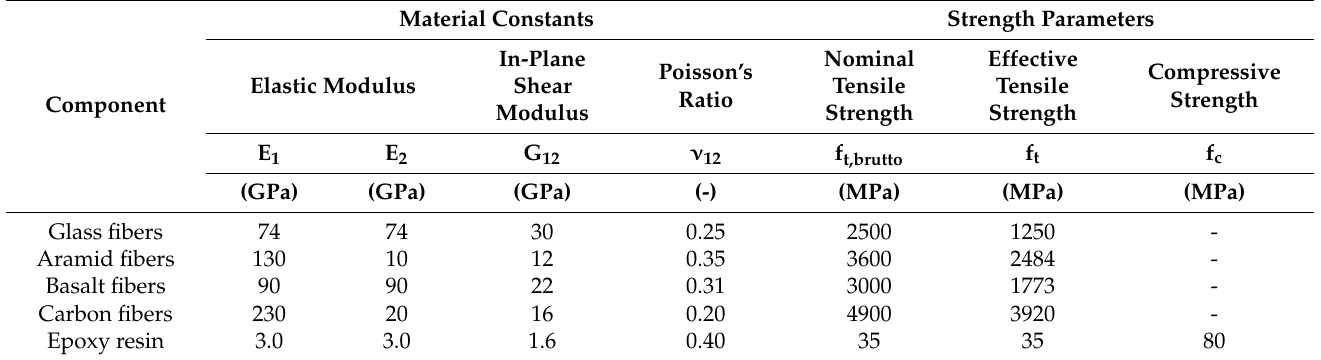
Table 6. The material constants and strength parameters for all types of fibers and epoxy resin [29]. Material Constants Strength